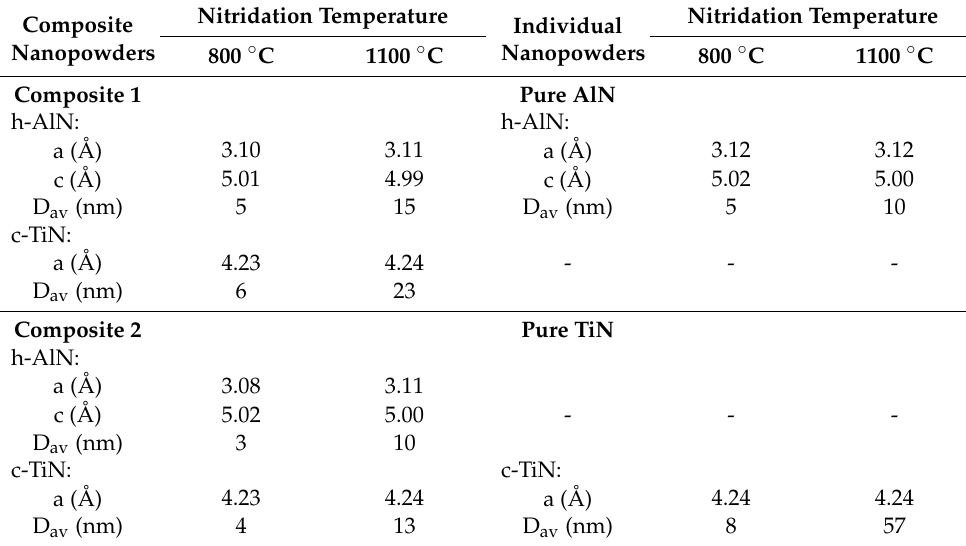
Table 1. XRD-derived cell parameters and average crystallite sizes determined for composite